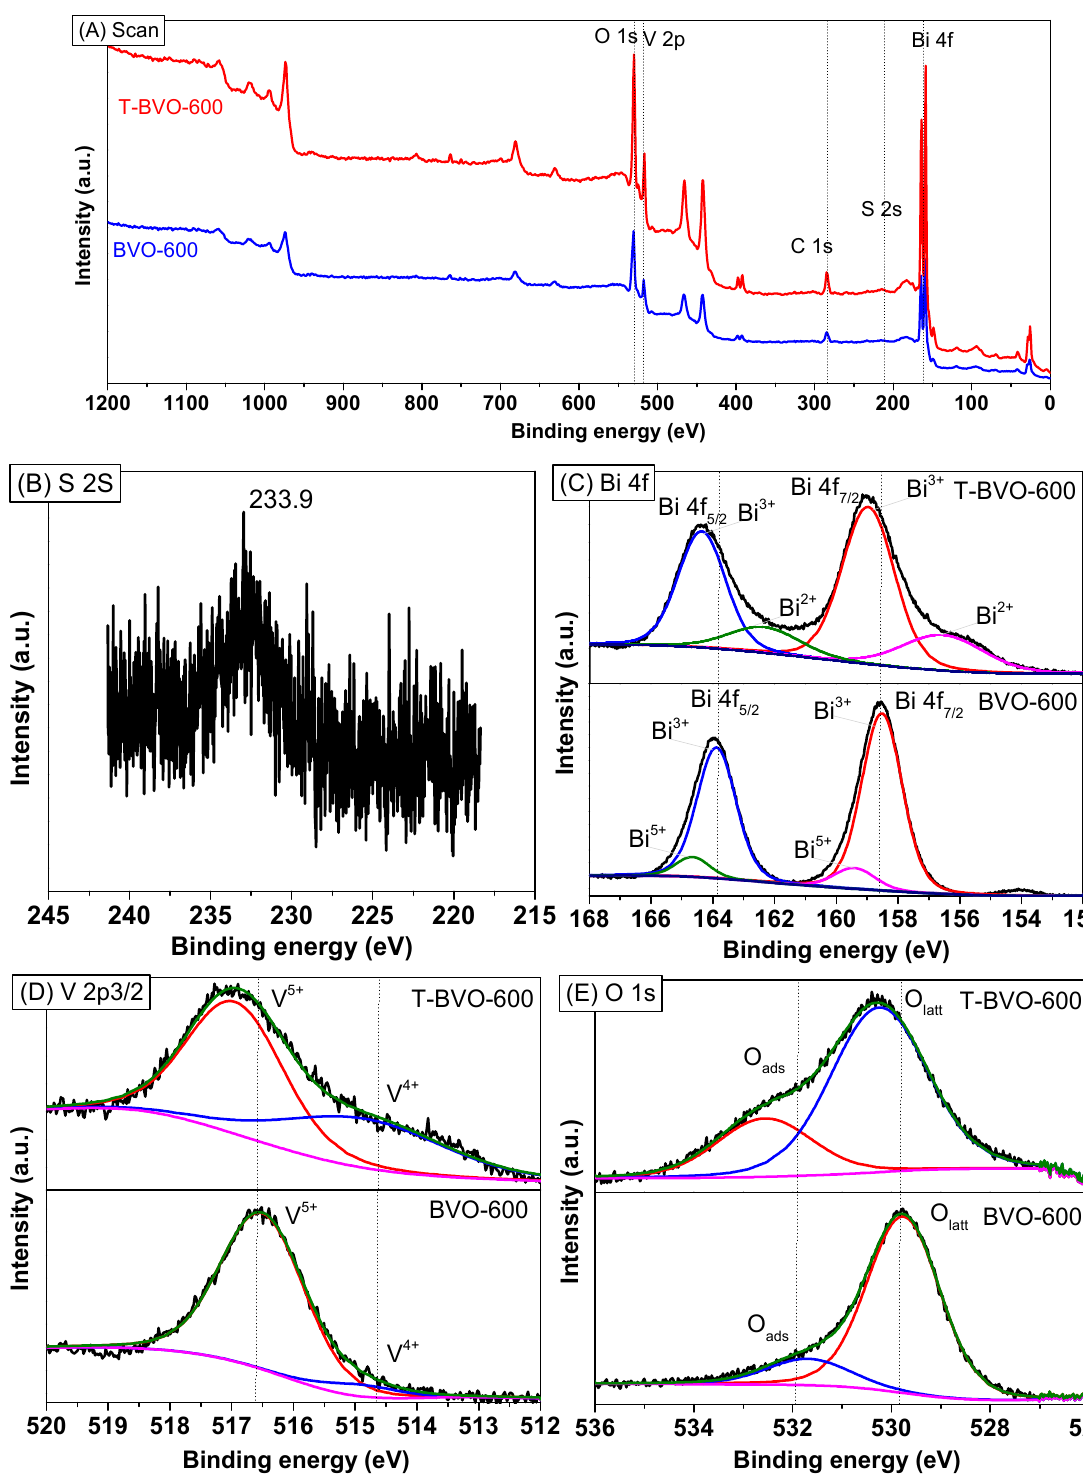
Figure 2. Full scan ( A ), S 2s ( B ), Bi 4f ( C ), V 2p3/2 ( D ), and O 1s ( E ) X-ray photoelectron spectroscopy (XPS) spectra of T-BVO-600 and BVO-600.